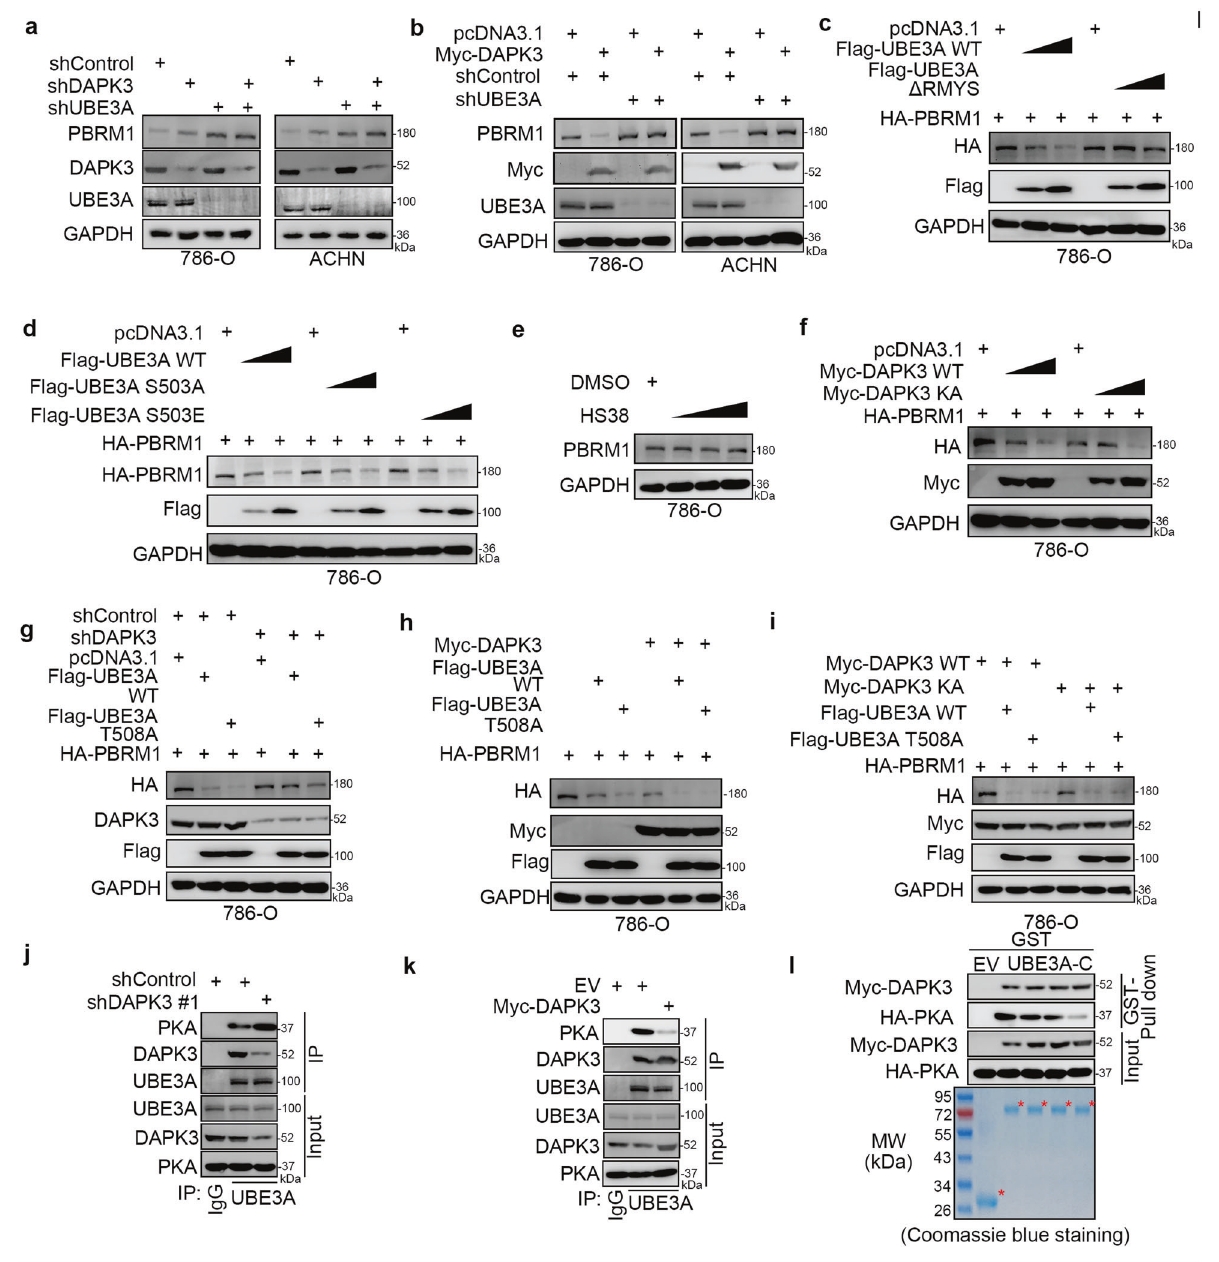
Fig. 4 DAPK3 competes with PKA to regulate the E3 ligase activity of UBE3A. a 786-O and ACHN cells were infected with indicated shRNAs. Seventy-two hours post infection, cells were harvested for western blotting analysis. b 786-O and ACHN cells were infected with shControl and shUBE3A for 48 h. Then, 786-O and ACHN cells were transfected with indicated plasmids for another 24 h. Cells were harvested for western blotting analysis. c 786-O cells were transfected with indicated plasmids for 24 h. The WCL of cells were subjected to western blotting analysis. d 786-O cells were transfected with indicated plasmids for 24 h. The WCL of cells were subjected to western blotting analysis. e 786-O cells were treated with 0, 1 µM, 5 µM, and 10 µM HS38 (the DAPK3 inhibitor) for 24 h. The WCL of cells were subjected to western blotting analysis. f 786-O cells were transfected with indicated plasmids for 24 h. The WCL of cells were subjected to western blotting analysis. g 786-O cells were infected with shControl and shDAPK3 for 48 h. Then, 786-O cells were transfected with indicated plasmids for another 24 h. Cells were harvested for western blotting analysis. h 786-O cells were transfected with indicated plasmids for 24 h. The WCL of cells were subjected to western blotting analysis. i 786-O cells were transfected with indicated plasmids for 24 h. The WCL of cells were subjected to western blotting analysis. j 786-O were infected with shControl and shDAPK3 for 72 h. The WCL of cells were subjected to western blotting analysis. k 786-O cells were transfected with indicated plasmids for 24 h. The WCL of cells were subjected to western blotting analysis. l Western blotting analysis of in vitro expressed DAPK3 and PKA GST-pulled down by the C-terminus of UBE3A.